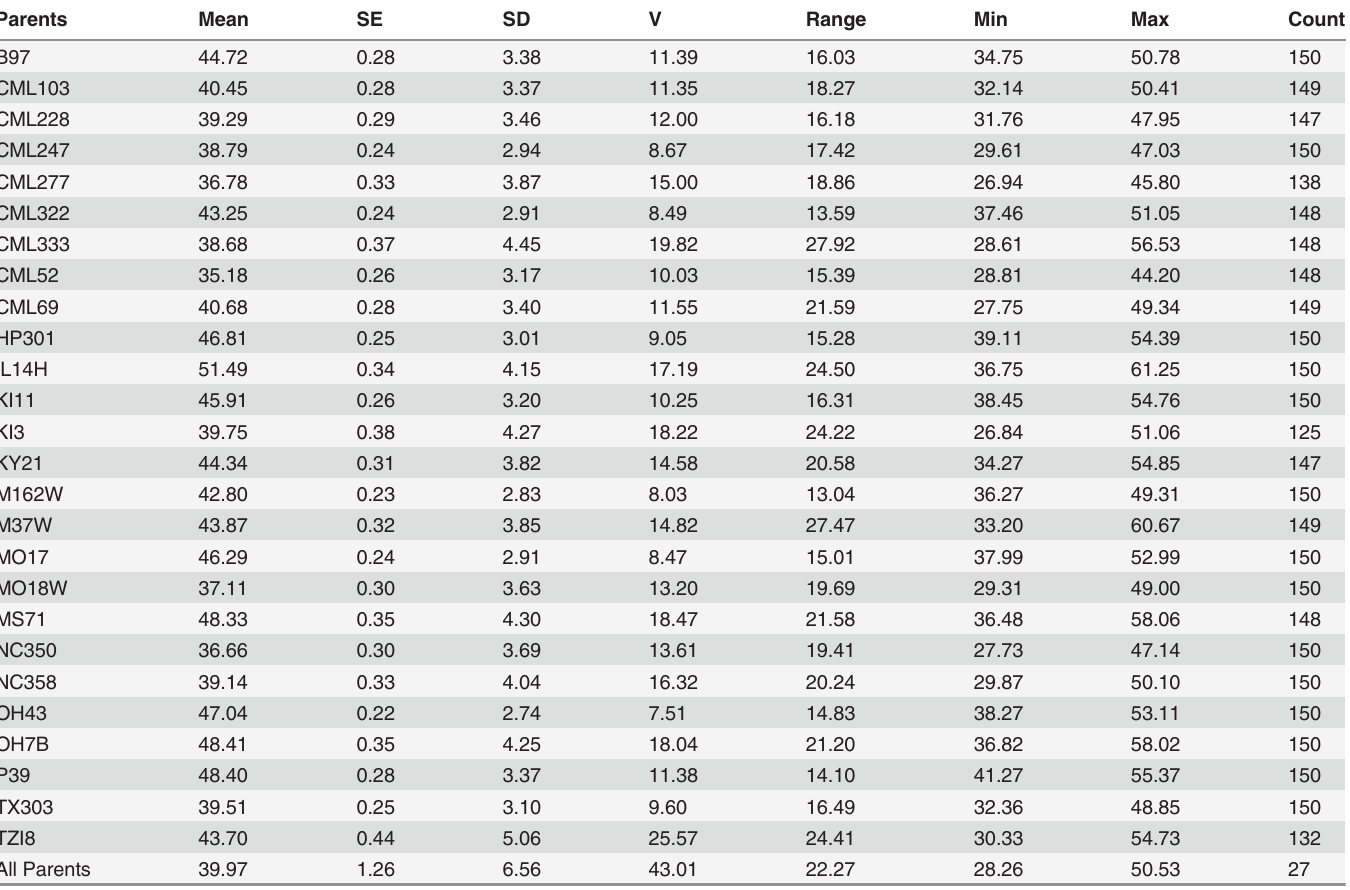
Table 1. AUDPC summary statistics for the nested association mapping population.